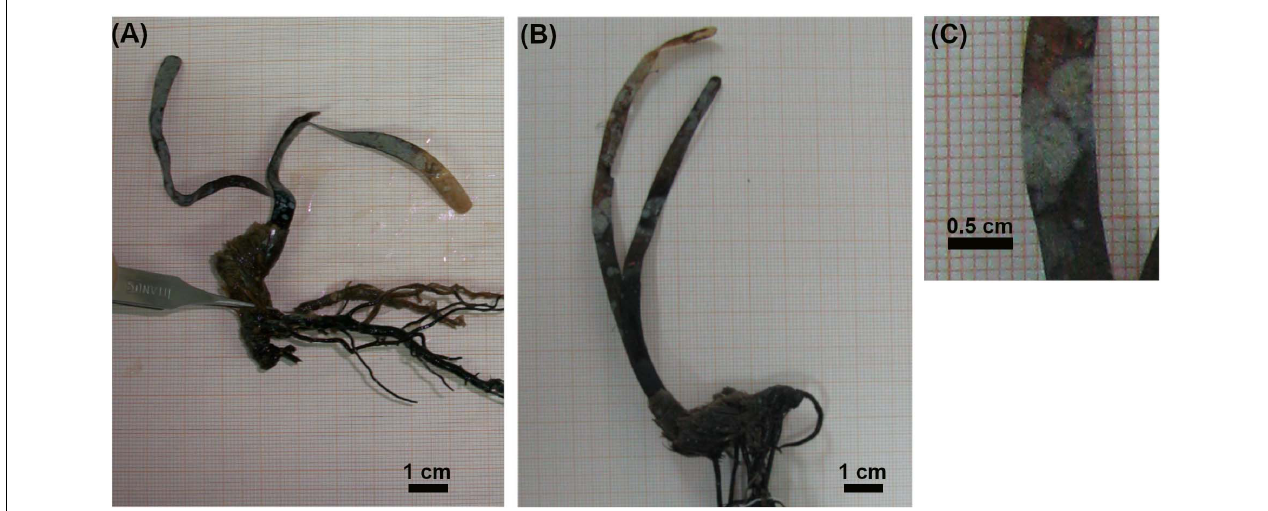
FIGURE 1 | Images of five-year old Posidonia oceanica seedlings grown on rock (A) or sand (B) substrate, and of epiphytes grown on leaves (C) .